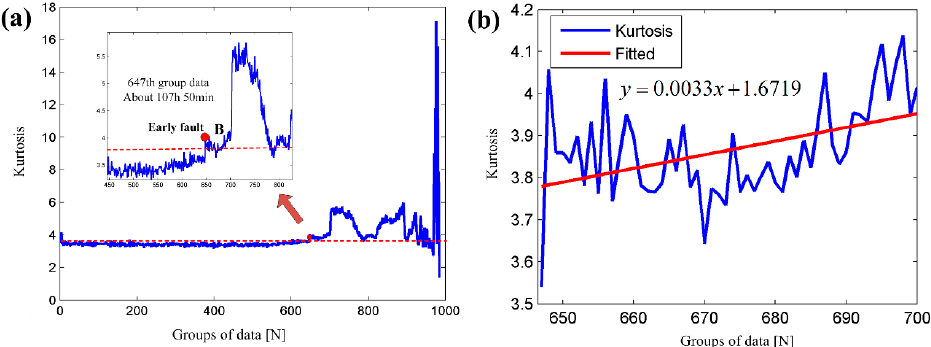
Figure 18. ( a ) The kurtosis value for the full life cycle of bearing 1; ( b ) The sensitivity value of kurtosis.